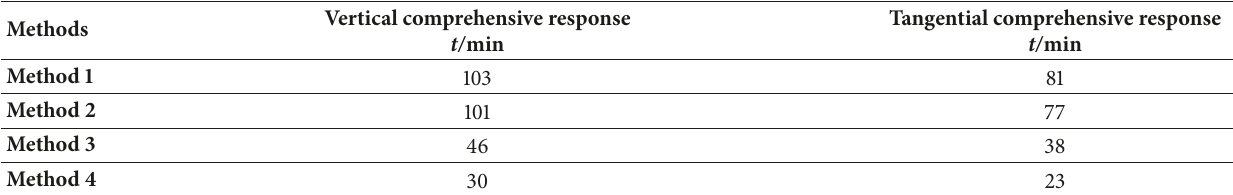
Table 6: Analysis times of four different methods.